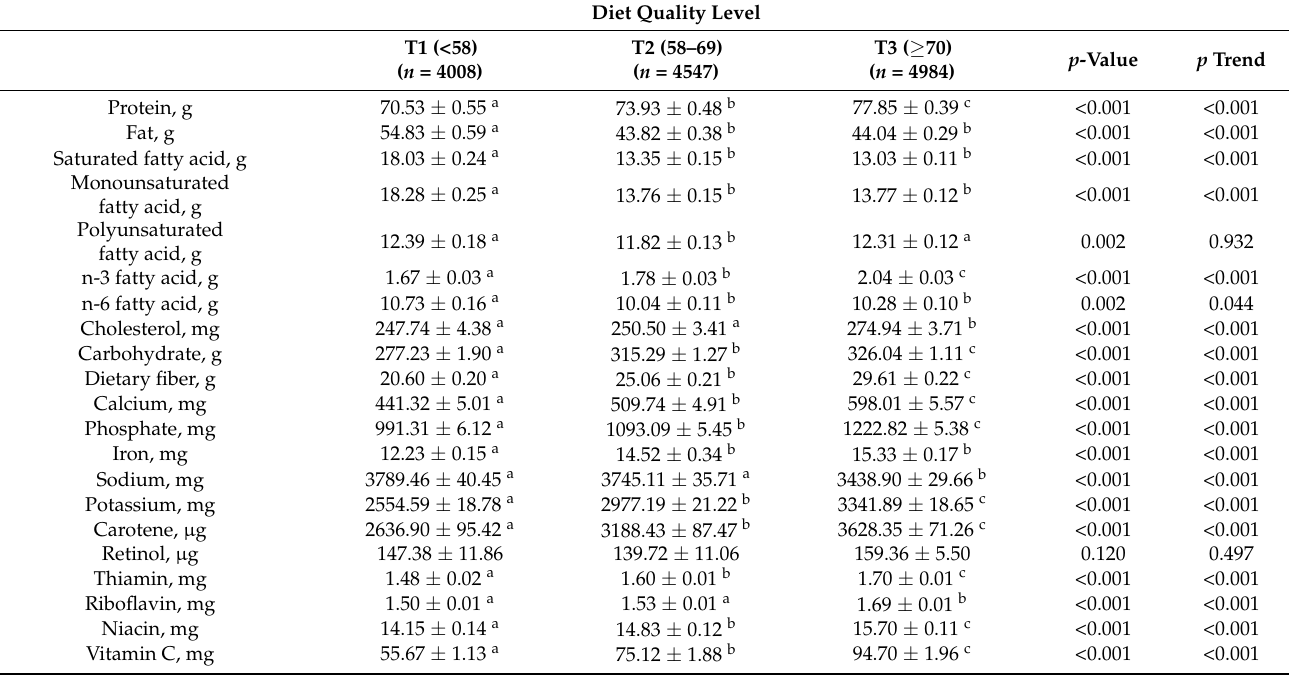
Table 5. Nutrient intakes of subjects according to diet quality